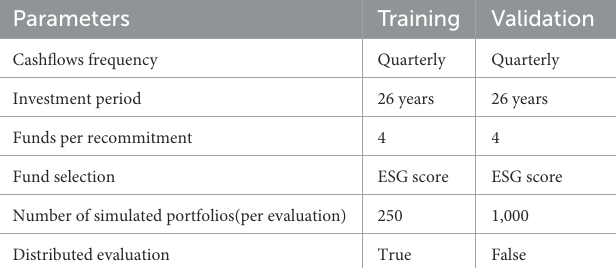
TABLE 4 Simulation parameters. Parameters